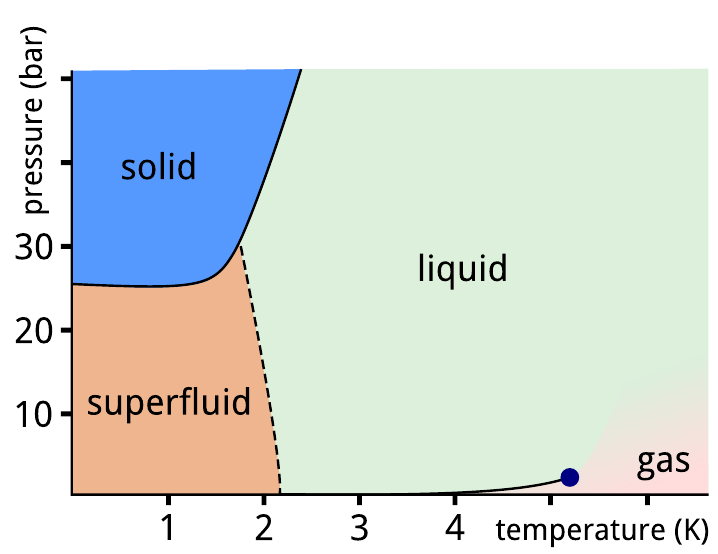
Figure 5.1: Phase diagram of helium-4. The different equilibrium phases as a func- tion of pressure and temperature are marked by different colours. Solid lines repre- sent the first-order phase transitions between liquid and a solid (involving the break- ing of a symmetry), and between liquid and gas (without breaking any symmetry). The liquid–gas transition line ends in a critical point (dark blue dot). The scale in- variance at this point is signalled for instance by its critical opalescence. Beyond this line it is no longer possible to clearly distinguish between a liquid and a gas, and there is no abrupt transition, but a smooth crossover between the two phases. The dashed line denotes the second-order phase transition from a liquid to a